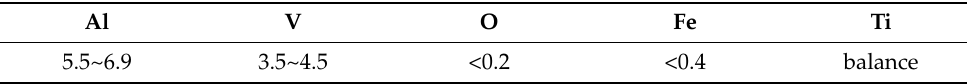
Table 1. Chemical composition of the Ti6Al4V alloy (wt.